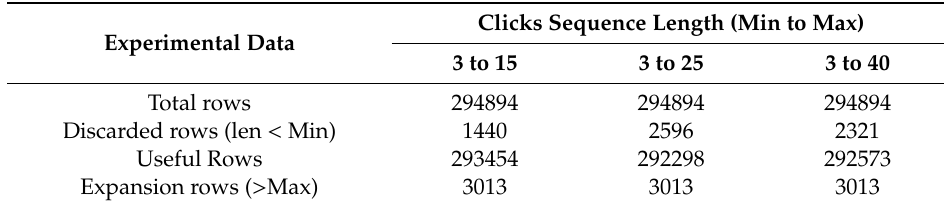
Table 4. Data characteristics based on click sequence length.